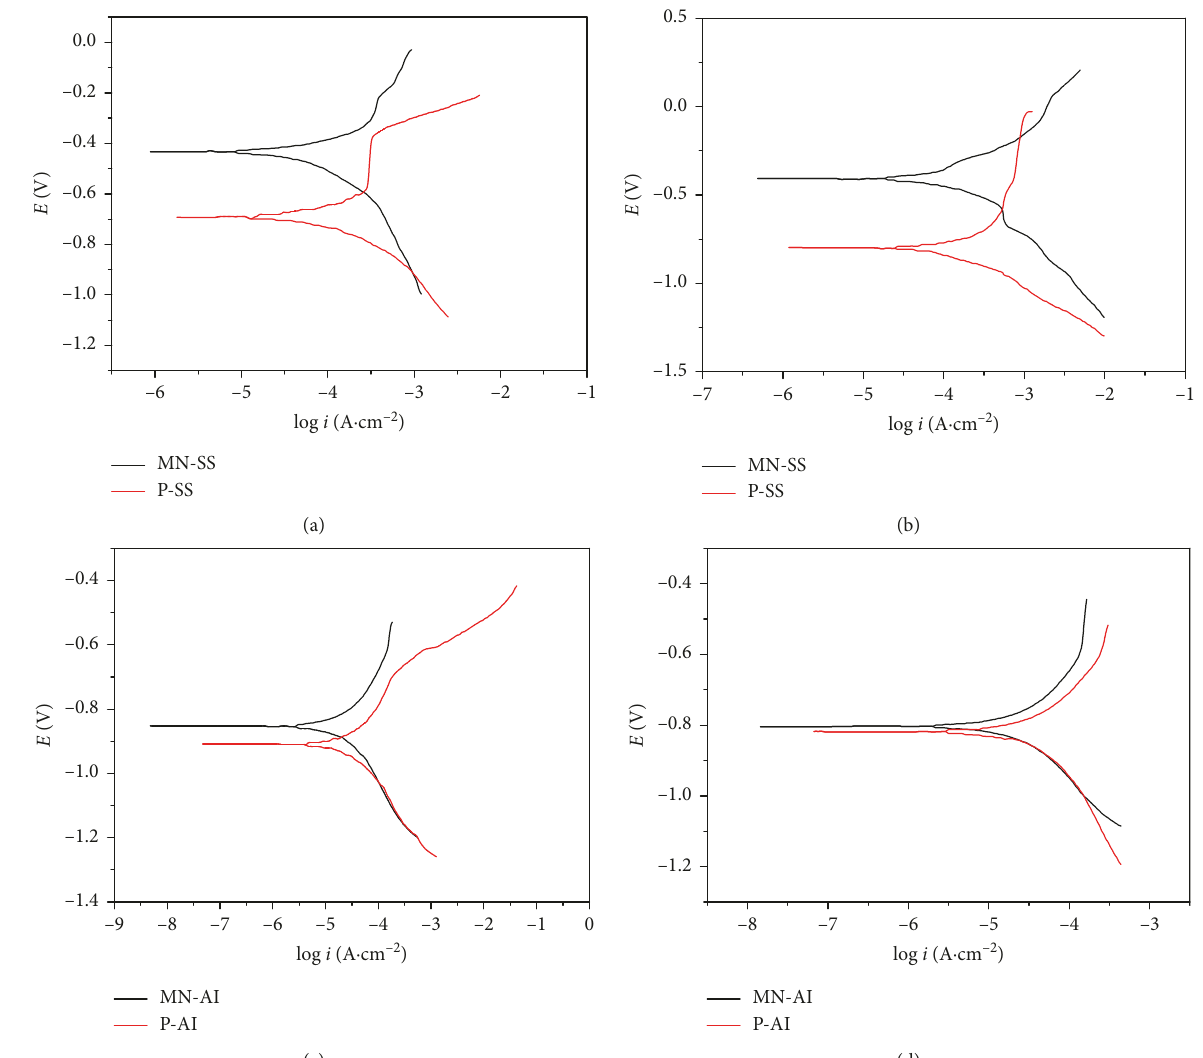
Figure 12: Potentiodynamic polarization curves of MN-SS, P-SS in (a) NaCl solution and (b) Na solution and (d) Na 2 SO 4